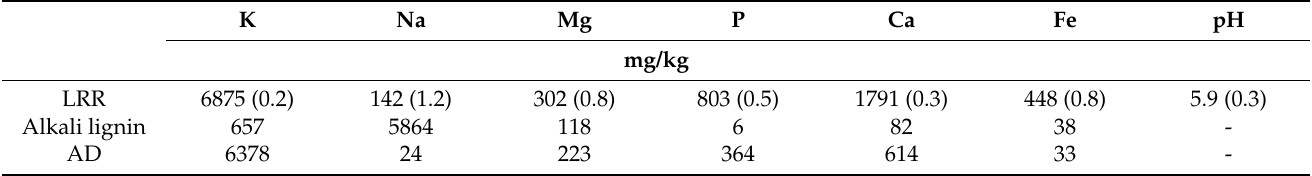
Table 2. ICP-MS analysis an pH of lignin rich residue (LRR); alkali lignin [17]; Arundo donax (AD) [18].